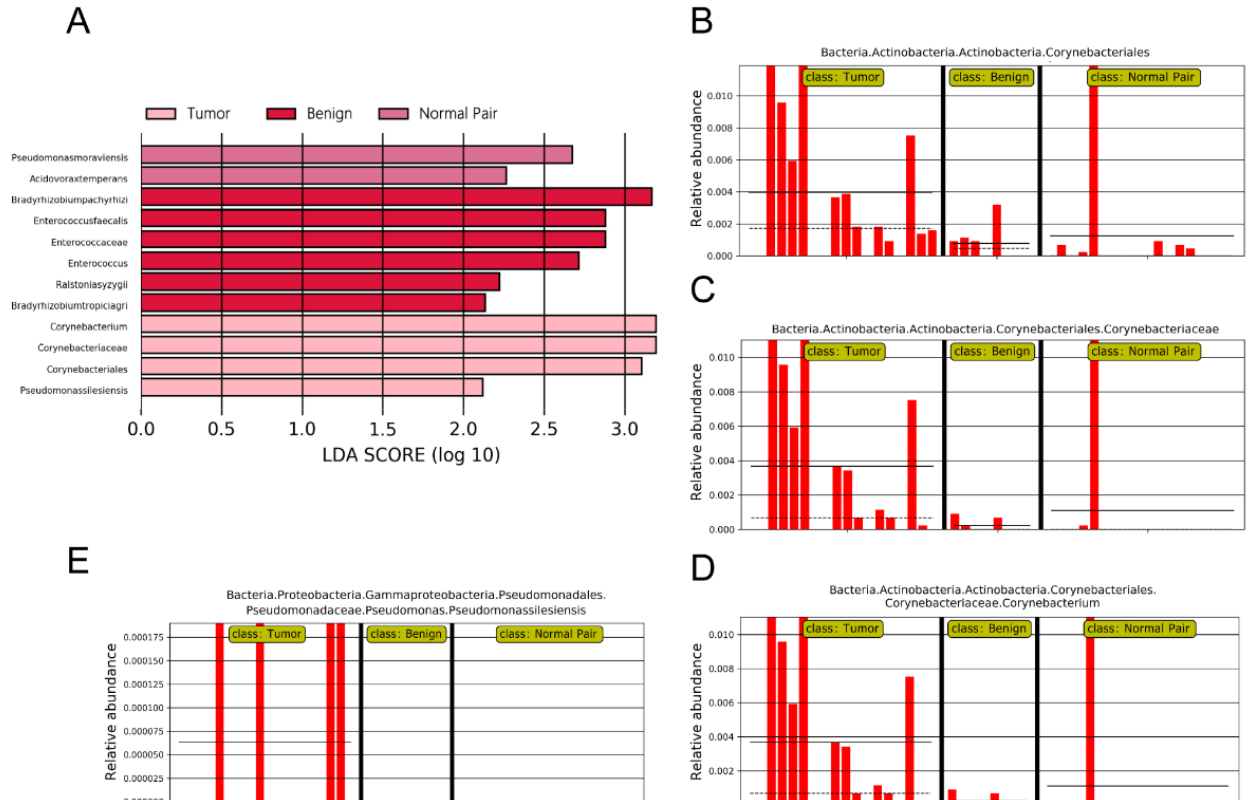
Figure 3. ( A ) LDA scores predict microbiota associated with benign, normal pair, and breast tumor tissue microbiomes. ( B – E ) Bar plots show the potential biomarkers which had relative abundance differences between tumor and other different types of tissues. Each bar represents a sample.